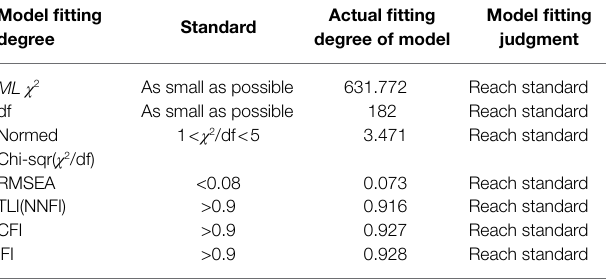
TABLE 5 | Index table of SEM model